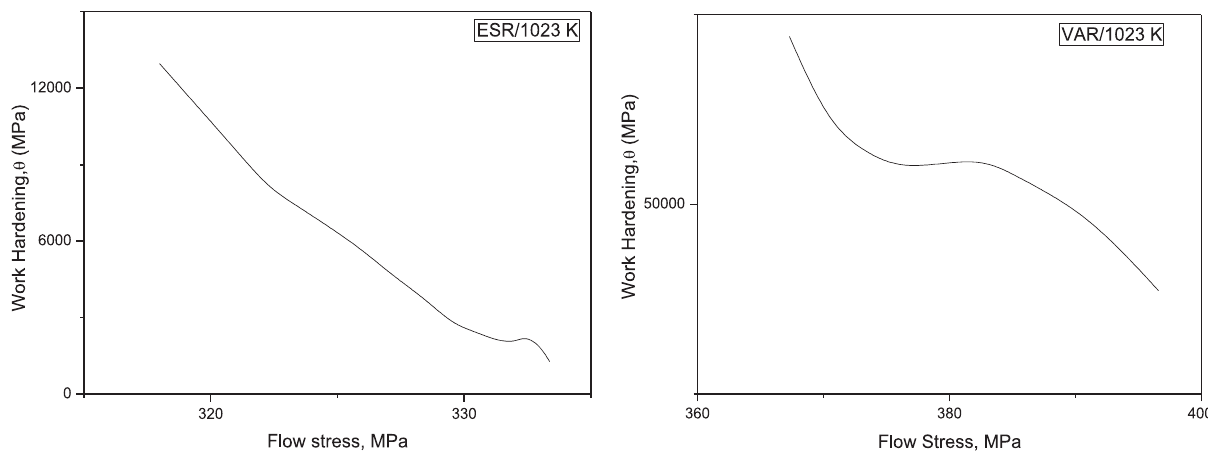
Fig. 10: Typical plots of work hardening rate as a function of flow stress in the DRX